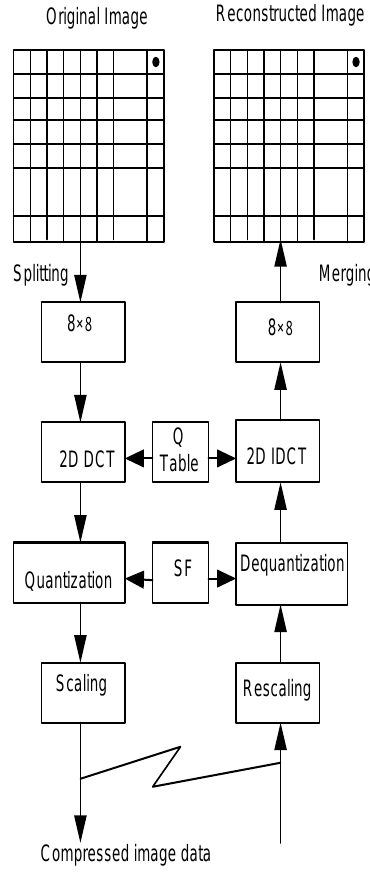
Figure 1 . Block diagram of the JPEG-based